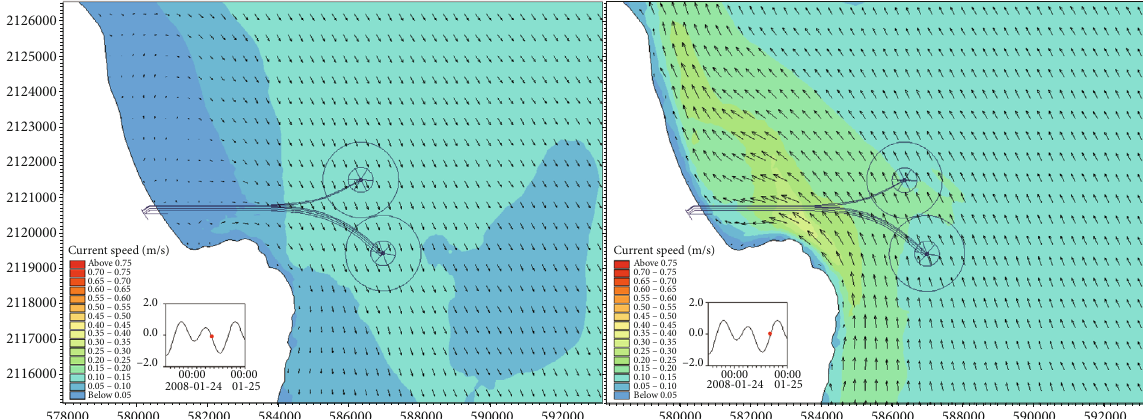
Figure 9: Depth-averaged current velocity during spring tide of the winter monsoon (left: ebb and right: fl ood